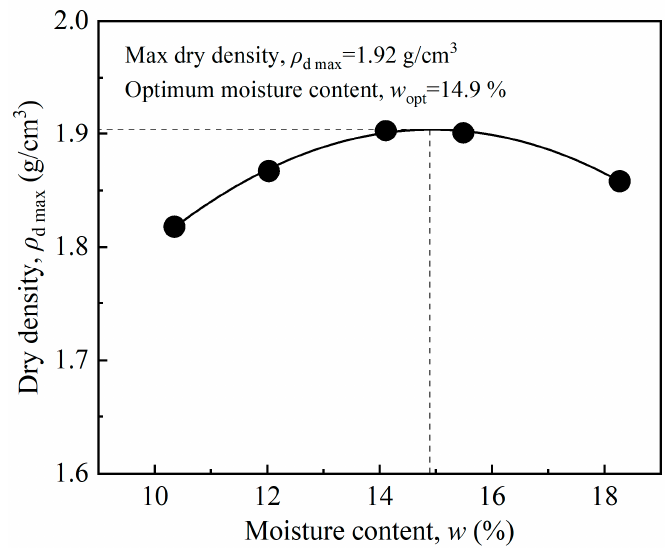
Figure 3. Compaction curve of shield tunnel abandoned soil. The relevant parameters of GGBS, MgO, and basalt fibers tested are listed in Table 2 and Table 3, respectively. The specific surface area and average particle size of GGBS were analyzed by the ASAP 2020 adsorption analyzer based on the nitrogen adsorption method. The activity index of GGBS was tested according to GB/T 18046 [31]. GGBS was classified and defined as S105 grade GGBS. The activity of MgO was tested by the water method, citric acid reaction method, etc. The basalt fibers in three lengths (6 mm, 9 mm, and 12 mm) of golden brown color, which are fast drawn by platinum–rhodium alloy, were produced by Bochao Engineering Materials Co., Changzhou, China. Table 1. Properties of shield residues tested.